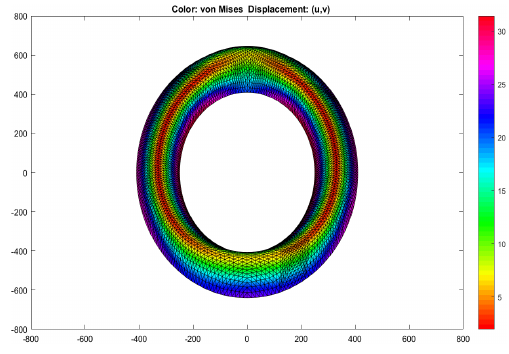
Fig. 7: Plot of von Mises